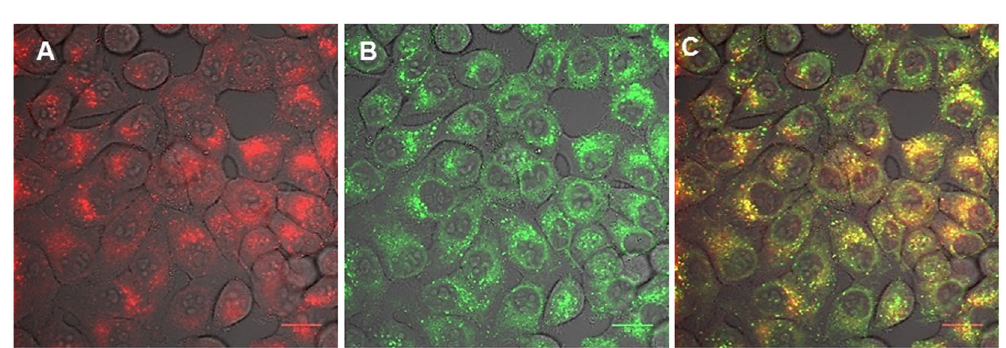
Figure 4. Cellular uptake and colocalisation of conjugate 8 with LysoTracker Green in KB cells using laser scanning confocal microscopy. Cells were incubated with the conjugate for 24 h. LysoTracker Green was applied to cells 30 min before imaging. ( A ) Conjugate alone (red), ( B ) LysoTracker Green (green), ( C ) merged ( A and B ). Scale bar: 20 μ